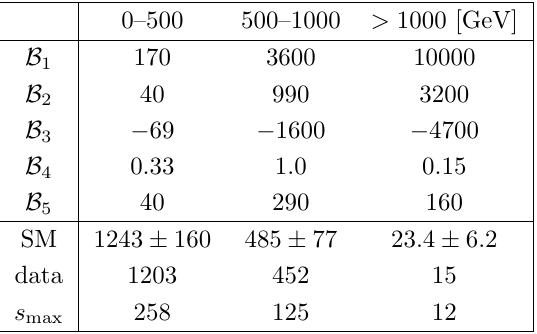
Table 3 . Coe(cid:14)cients in TeV 4 and rounded to two signi(cid:12)cant (cid:12)gures for pp ! (cid:28)N obtained upon recasting the experimental analysis of ref. [26] for L = 35 : 9 fb (cid:0) 1 . Note that eq. 2.1 is obtained p under the assumption s (cid:29) m W , so B 4 ; 5 in the (cid:12)rst bin should not be taken